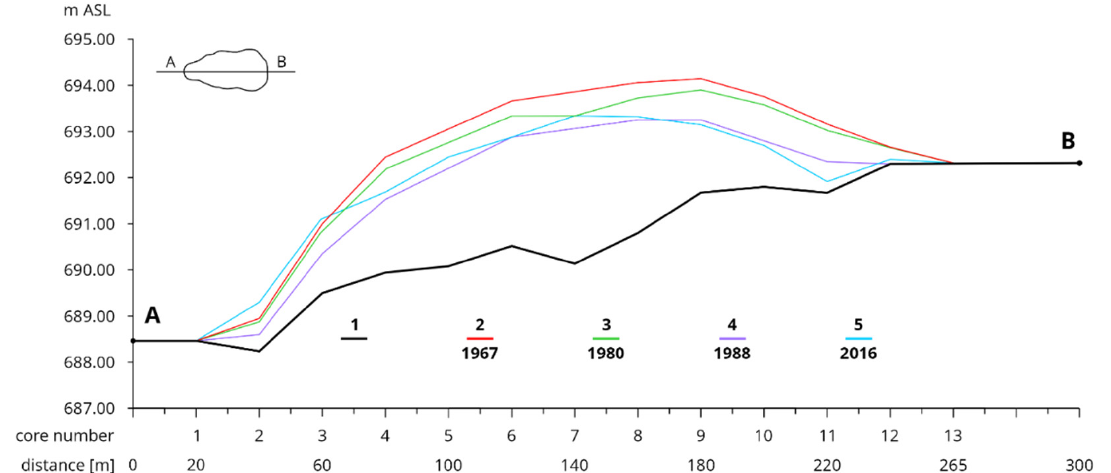
Figure 3. Changes in the longitudinal transect of the “Wo ł osate” bog dome in the Western Bieszczady Mountain in the years 1967–2016 (1—mineral substrate, 2—the dome surface on 15 May 1967, 3—the dome surface on 12 June 1980, 4—the dome surface on 26 July 1988, 5—the dome sur- face on 5 May 2016).